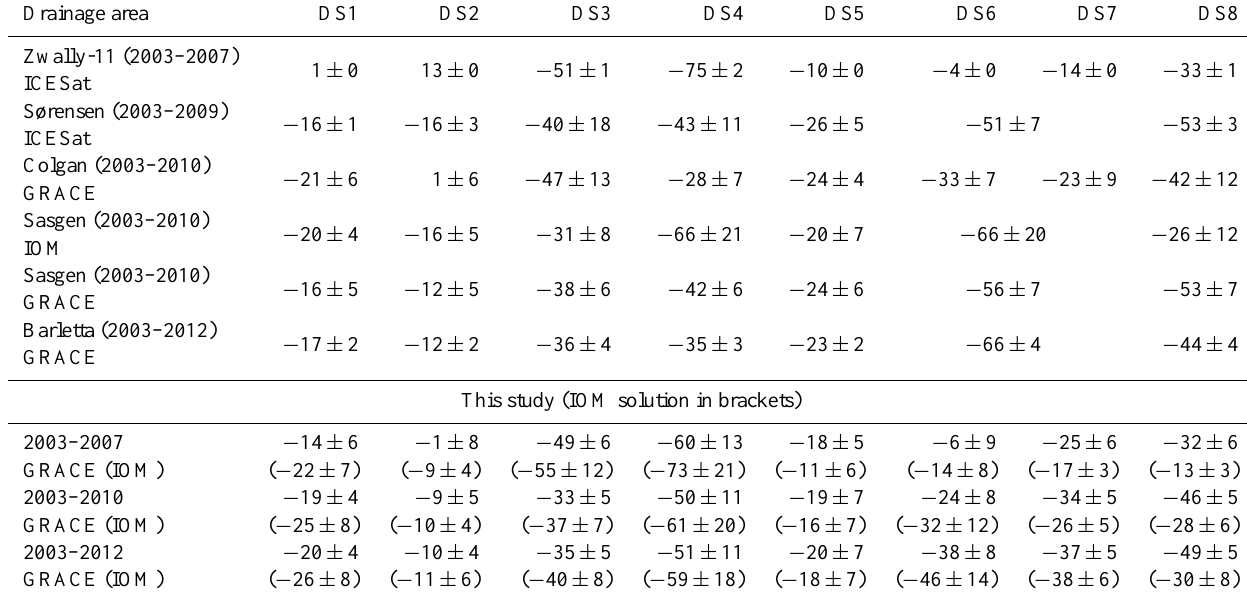
Table 1. The rates of mass changes in GrIS regions based on satellite gravity data (GRACE), IOM output and altimetry data (ICESat), in Gtyr − 1 . The sources are Zwally et al. (2011), Sasgen et al. (2012), Barletta et al. (2013), Colgan et al. (2015b), Groh et al. (2014) and Sørensen et al. (2011). Note that the IOM solution from this study is shown in brackets. Drainage area DS1 DS2